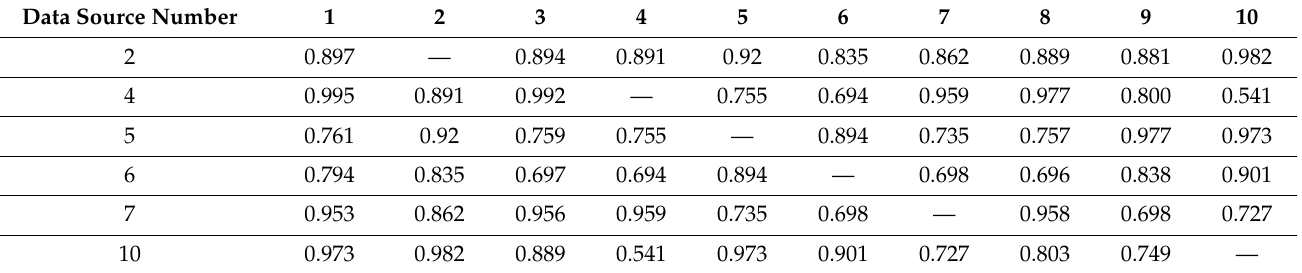
Table 3. Calculation results of the two dimensional similarity between missing data sources and remaining data sources.